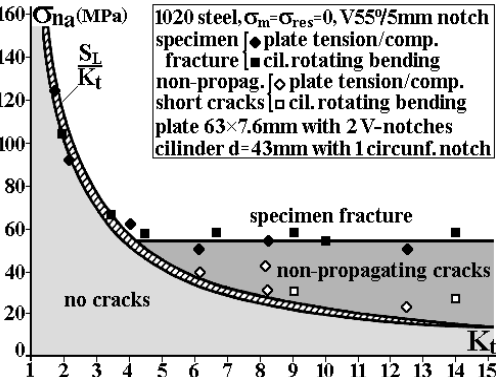
Figure 1: Classical data showing that non-propagating fatigue cracks are generated at the notch roots if S